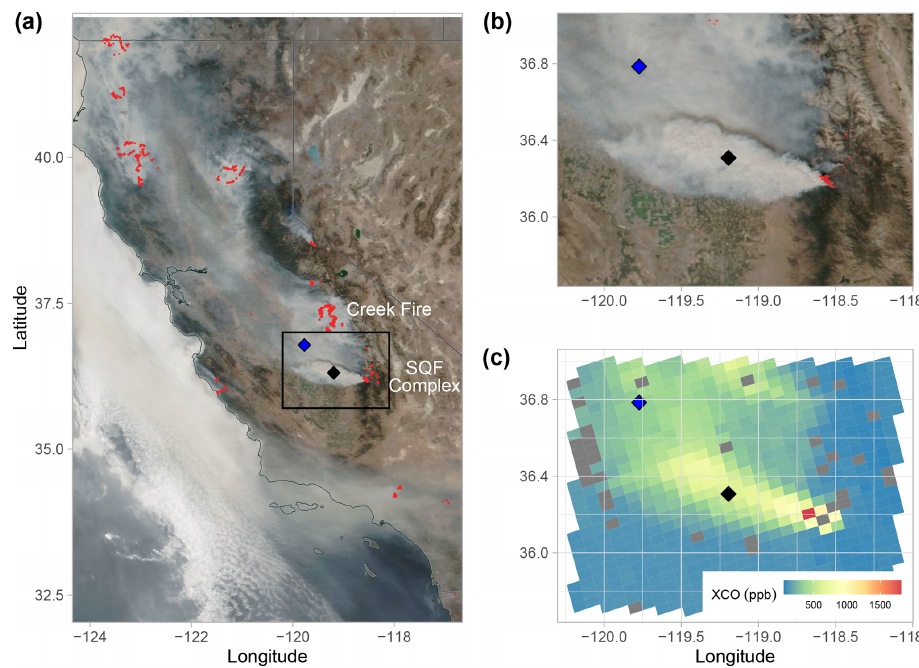
Figure 1. (a) Satellite imagery, captured by NOAA-20 Visible Infrared Imaging Radiometer Suite (VIIRS), of heavy smoke in California on 12 September 2020, highlighting fire and thermal anomalies in red (NASA Worldview; https://worldview.earthdata.nasa.gov/, last access: 15 July 2022), with a black diamond shape showing the EM27/SUN measurement location and a blue diamond shape showing the AERONET observational site. (b) The inset shows more detail of the smoke plume within the SJV from the SQF Complex in the Sierra Nevada. (c) The inset of the TROPOMI X CO overpass on 12 September 2020 at